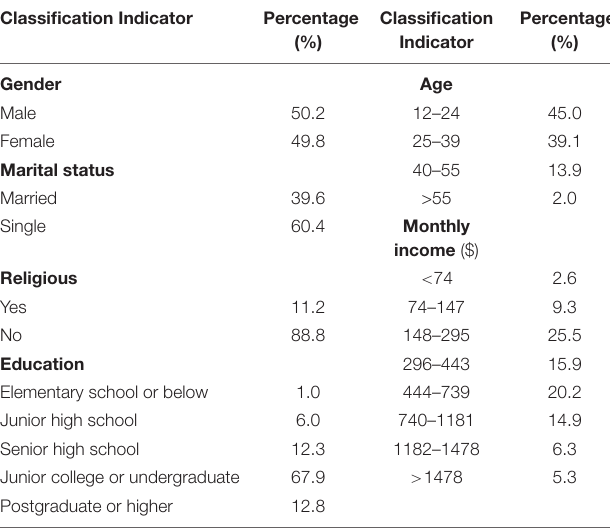
TABLE 1 | Recipient